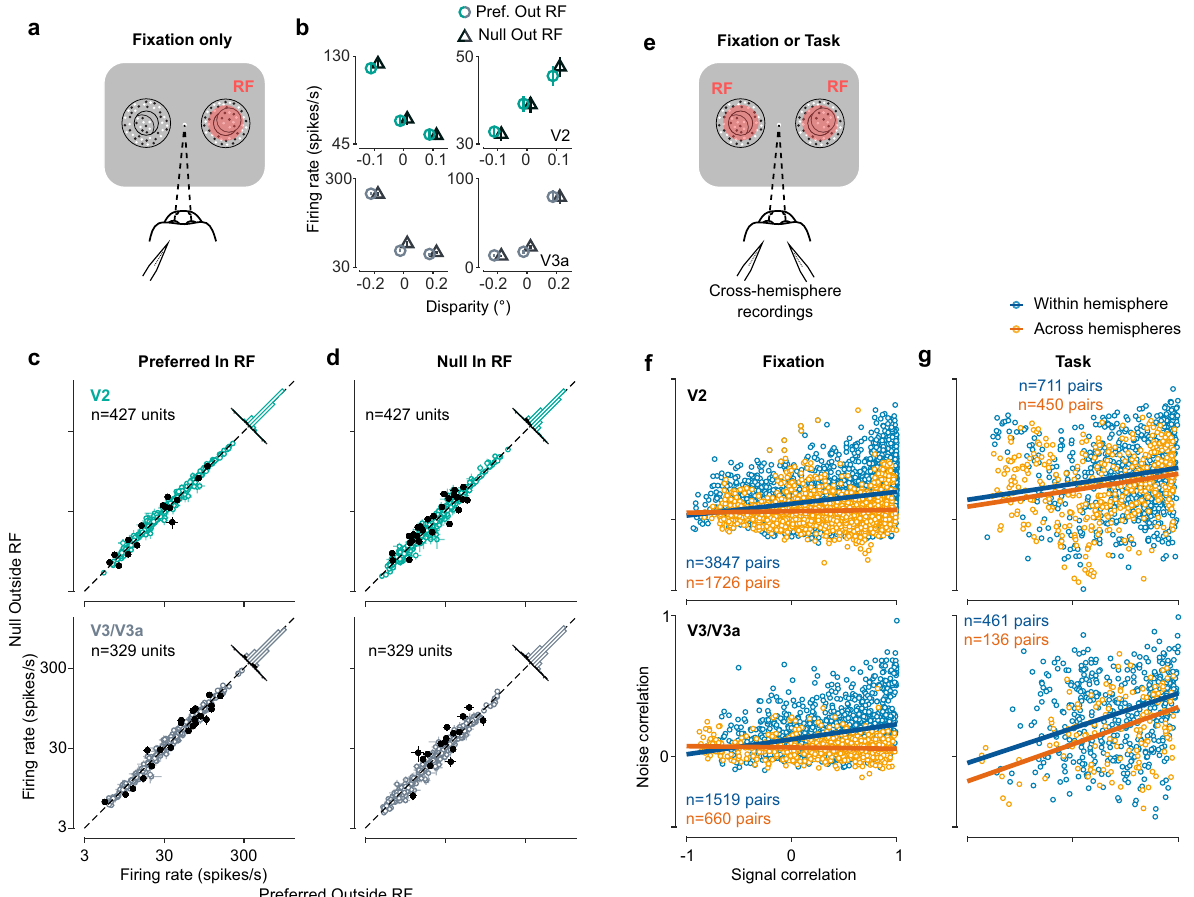
Fig. 3 Choice correlations for the irrelevant stimulus do not result from the stimulus outside the receptive fi eld, nor from noise correlations in the absence of a task. a Fixation task with one stimulus presented inside the receptive fi eld, and one stimulus in the opposite hemi fi eld. b Disparity tuning curves of four example units (V2, top row; V3/V3a, bottom row) as a function of the disparity of the stimulus inside the receptive fi eld, plotted separately (labels) for the disparity of the stimulus in the opposite hemi fi eld. Data points are horizontally offset for visibility. Error bars show s.e.m. n = 10 – 40 repeats per condition). c Firing rates to the preferred disparity (top: V2, bottom: V3/V3a) inside the receptive fi eld as a function of the disparity of the stimulus in the opposite hemi fi eld. Histograms show fi ring rate ratios. Filled data points depict units whose fi ring rates signi fi cantly deviate from unity ( p < 0.05, two- sample t -test). Error bars show s.e.m. d as c but for the null disparity inside the receptive fi eld. e Bi-hemisperic recordings during fi xation or task performance. f Noise correlations between pairs of units within (blue) and across (orange) hemispheres are plotted as a function of their signal correlation, during fi xation and g during performance of the task for V2 (top) and V3/V3a (bottom). Note the change in the regression slope within versus across hemispheres during fi xation but not during task